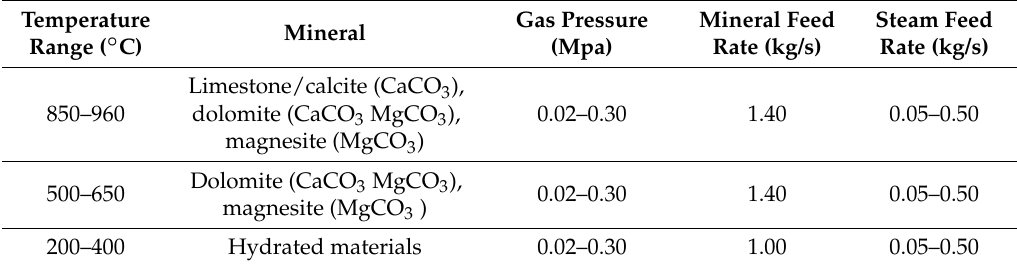
Table 1. Temperature ranges for different calcination processes proposed by Sceats et al.